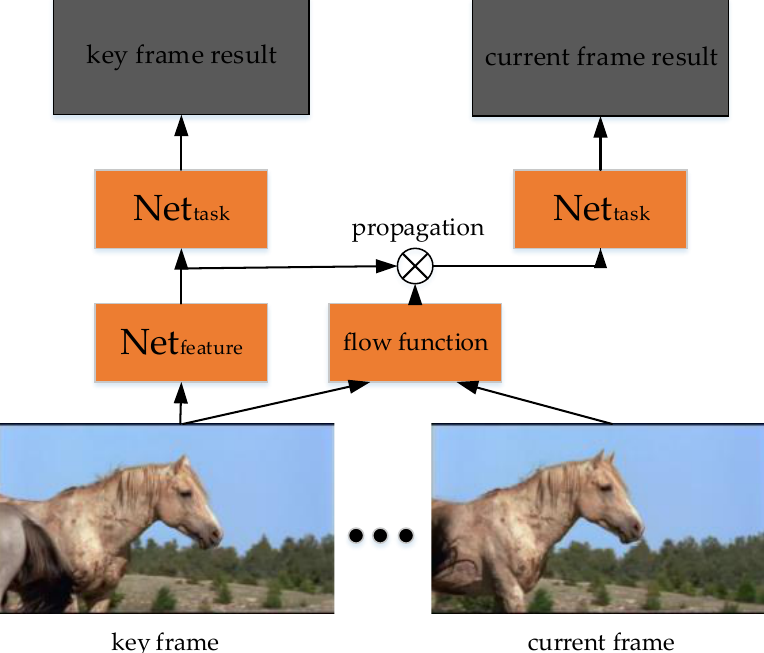
Figure 18. The illustration of DFF. Net feature is a feature extractor (backbone), Net task is a detector, flow function is the optical flow net [137]. The video frames are from YTO dataset.